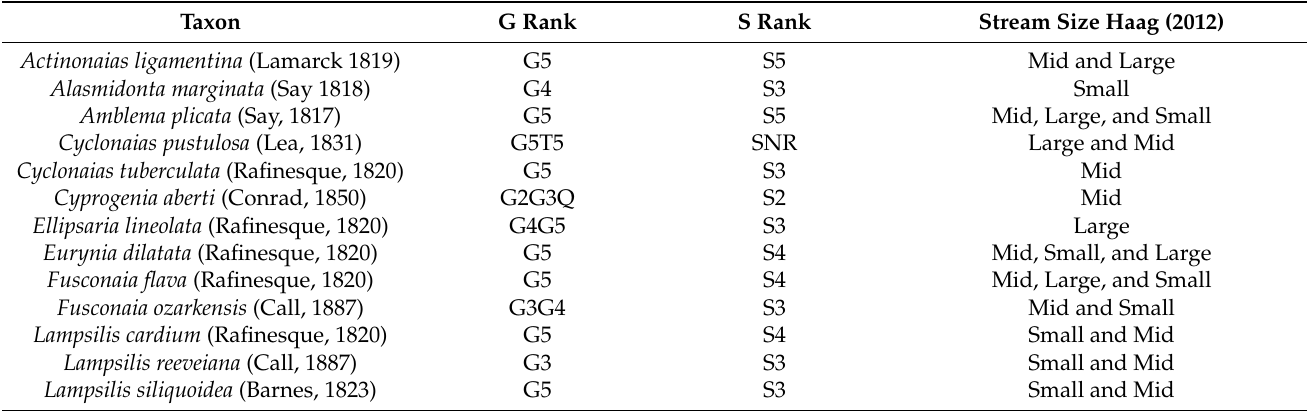
Table 1. Species list of Strawberry River freshwater mussels collected at 59 stations and stream size which a species is strongly associated as reported by Haag [3]; species not categorized by Haag [3] are indicated with a dash (-); stream size guild designation listed from highest to lowest dominance. Nomenclature follows Williams et al. [17]. G1 = critically imperiled globally, G2 = imperiled globally because of rarity, G3 = very rare or found locally, G4 = apparently secure globally, G5 = demonstrably secure globally; Q in the global rank indicates the element’s taxonomic classification is uncertain, S1 = extremely rare, S2 = very rare, S3 = rare to uncommon, S4 = common, apparently secure, S5 = common and secure, SNR = Unranked, the state rank not yet assessed, T = subranks are given to global ranks when a subspecies, variety, or race is considered at the state level. The subrank is made up of a "T" plus a number or letter (1, 2, 3, 4, 5, H, U, X) with the same ranking rules as a full species. Global (G) and State (S) rankings obtained from Arkansas Natural Heritage Commission database